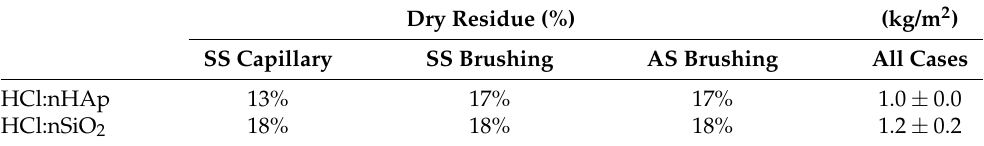
Table 6. Final dry residues measured on treated sound stone (SS) and aged stone (AS) samples.